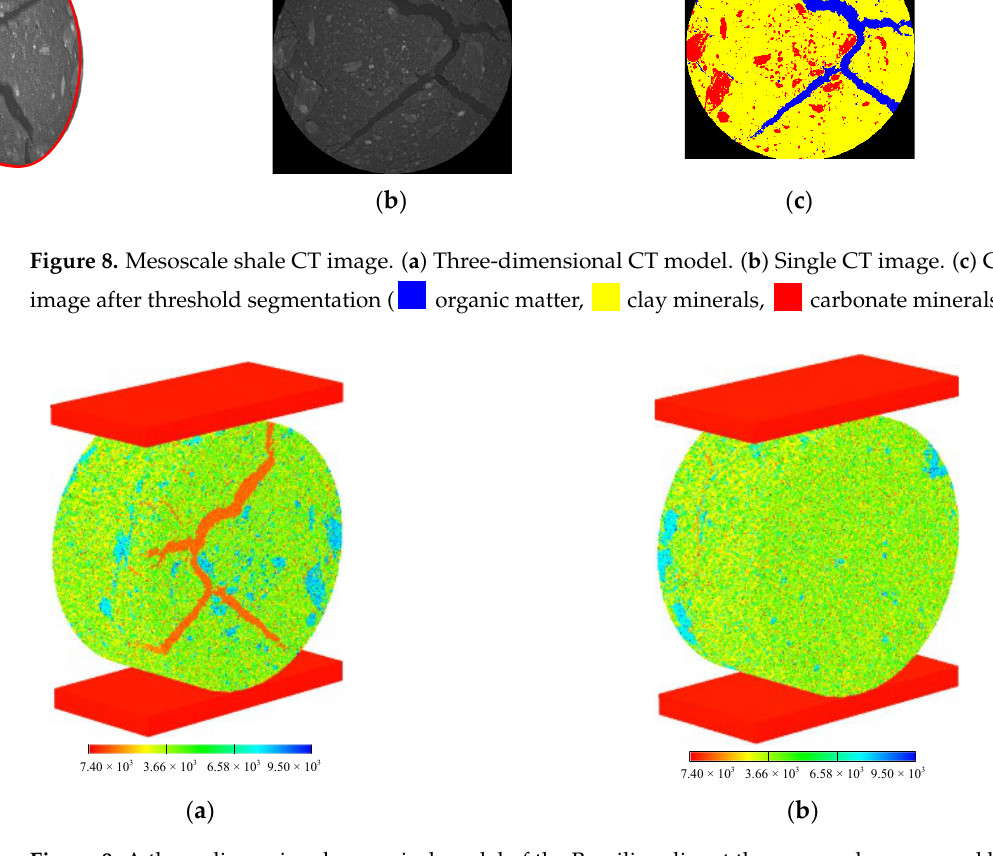
Figure 9. A three-dimensional numerical model of the Brazilian disc at the mesoscale, expressed by elastic modulus. ( a ) is the front view, and ( b ) is the back view ( organic matter, clay minerals, carbonate minerals).